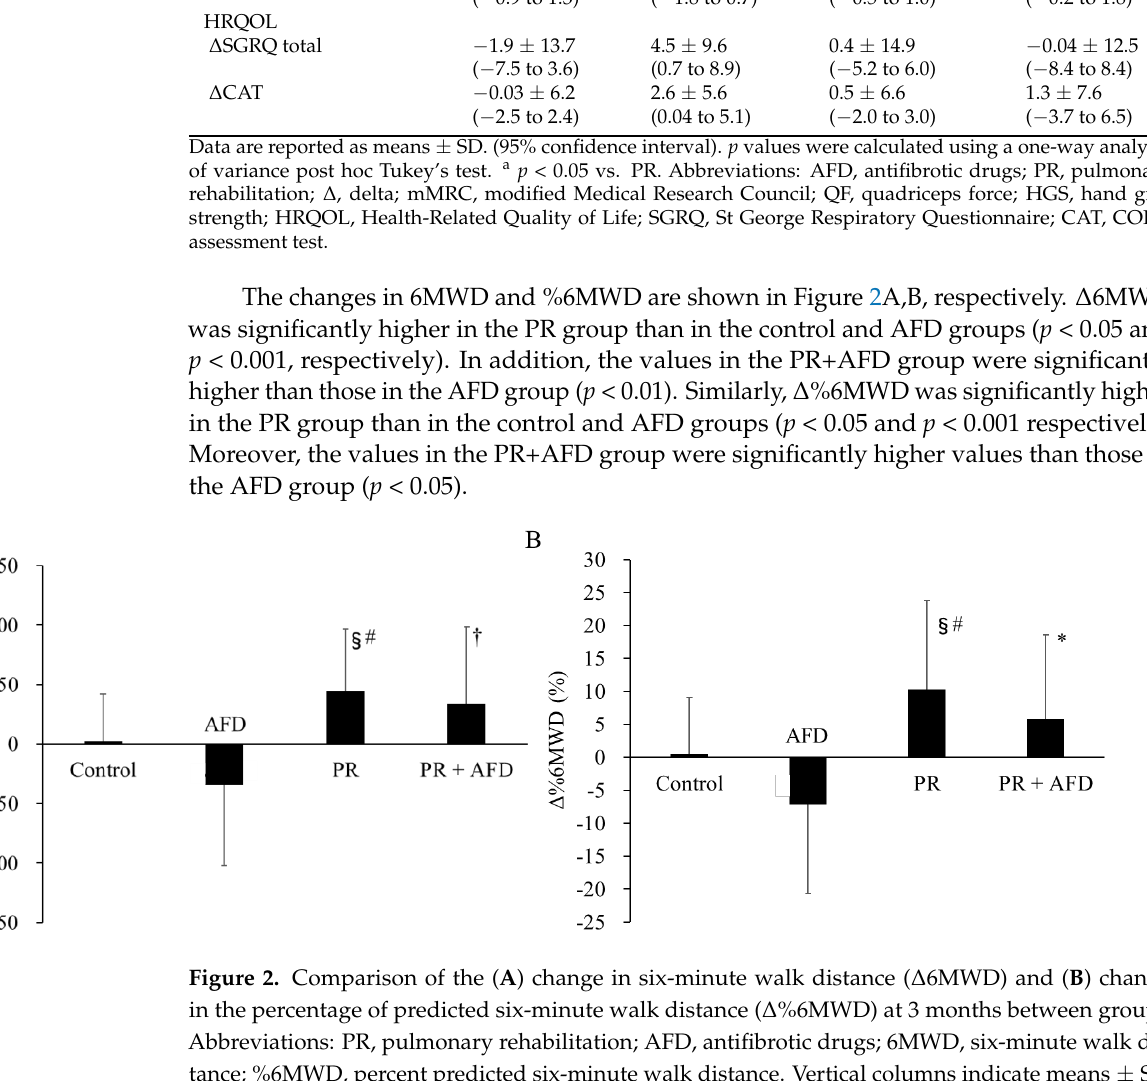
Table 3. Comparison of the change between baseline and 3 months between the groups.